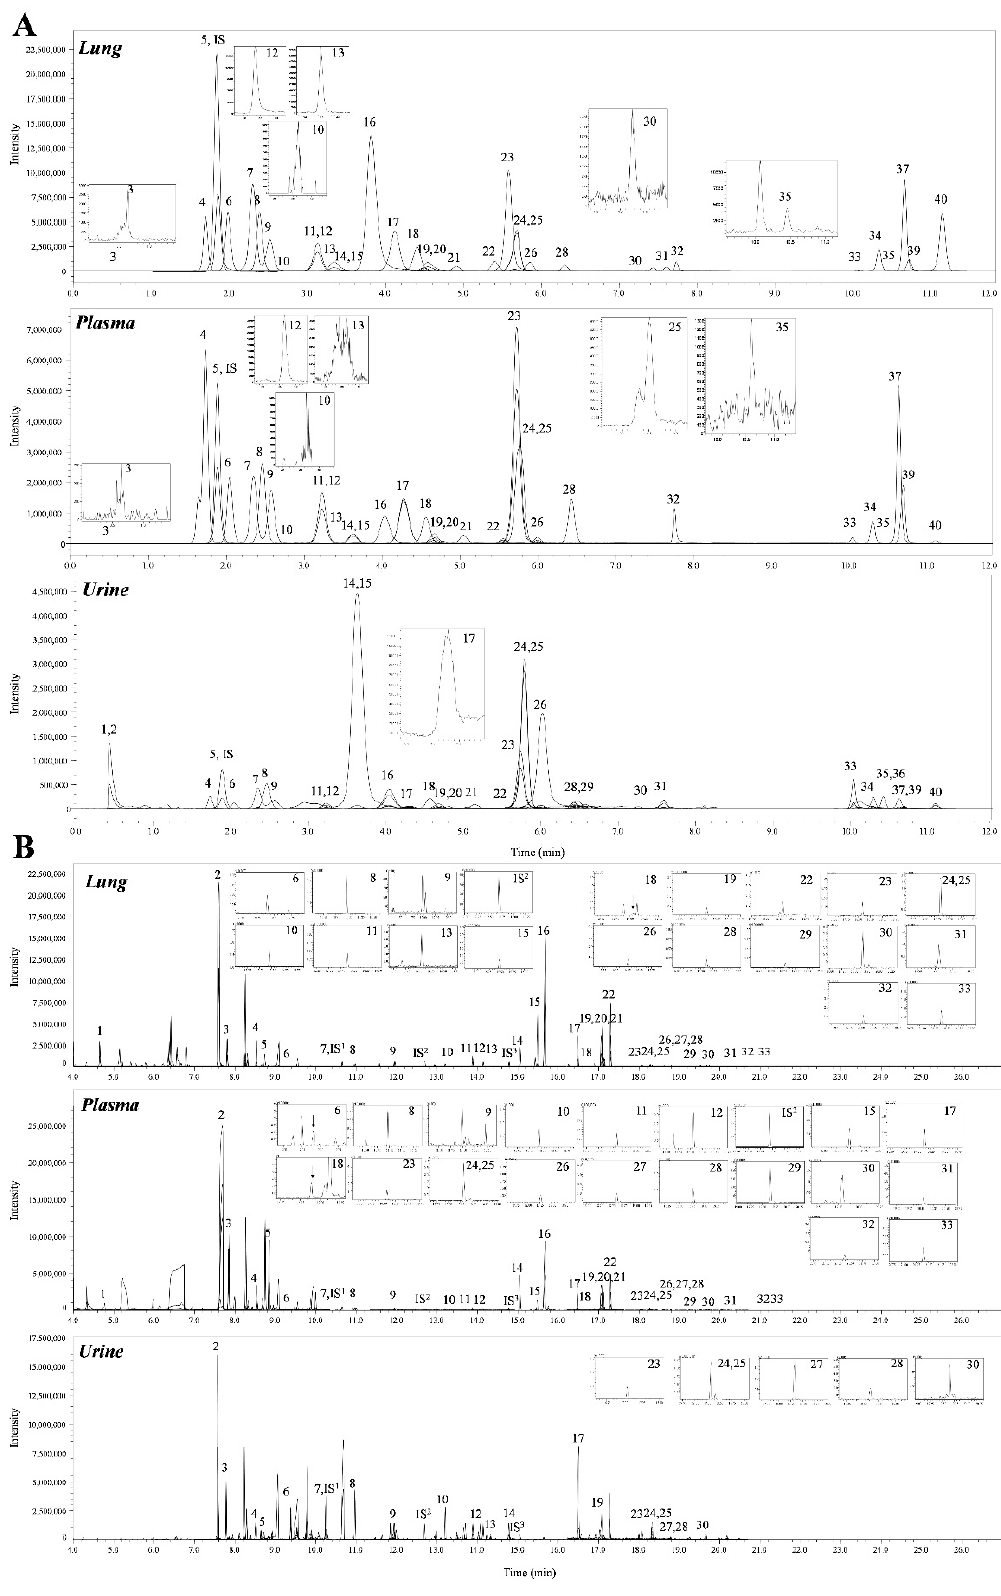
Figure 1. Representative SRM chromatograms of LC-MS/MS ( A ) and GC-MS/MS as MO/TBDMS derivatives ( B ) in lung, plasma, and urine. The peak numbers of LC-MS/MS correspond to those in Table S8, the peak numbers of GC-MS/MS correspond to those in Table S9.